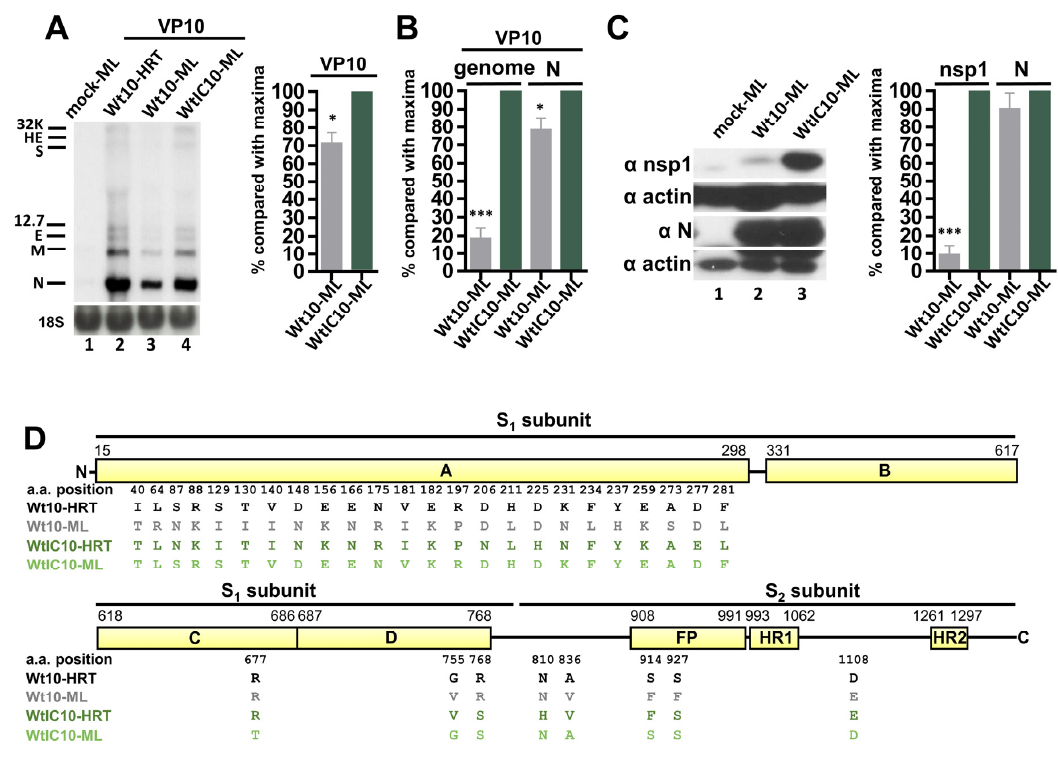
Figure 6. Adaptation capability of the selected BCoV variant WtIC10 in ML cells. ( A ) Left panel: determination of BCoV RNA synthesis from HRT-18 infected with Wt (Wt10-HRT, lane 2) or from ML cells infected with Wt10 (Wt10-ML, lane 3) or WtIC10 (WtIC10-ML, lane 4) at VP10 by Northern blotting. Right panel: relative amounts of BCoV RNA from ML cells infected with Wt10 or WtIC10 at VP10 based on the results shown in the left panel. ( B ) Relative amounts of genome and subgenome (represented by sgmRNA N) from fresh ML cells infected with Wt10 or WtIC10 at VP10 as measured by RT-qPCR. ( C ) Left panel: coronavirus protein synthesis from the genome (represented by nsp1) and subgenome (represented by N protein) from ML cells infected with Wt10 or WtIC10 at VP10 by Western blotting. Right panel: relative amounts of nsp1 and N protein between Wt10 and WtIC10 based on the results shown in the left panel. ( D ) Linear schematic of BCoV S protein showing the comparison of the aa sequences identified from HRT-18 cells infected with Wt at VP10 (Wt10-HRT, i.e., Wt10 in Figure 4), ML cells infected with Wt at VP10 (Wt10-ML), HRT-18 cells infected with Wt in the presence of poly IC at VP10 (WtIC10-HRT, i.e., WtIC10 in Figure 4) and ML cells infected with 12.7 kDa protein, E: envelope protein, M: membrane protein, N: nucleocapsid protein, 18S: 18S rRNA, FP: fusion peptide, HR1: heptad repeat 1, HR2: heptad repeat 2. The values in ( A – C ) represent